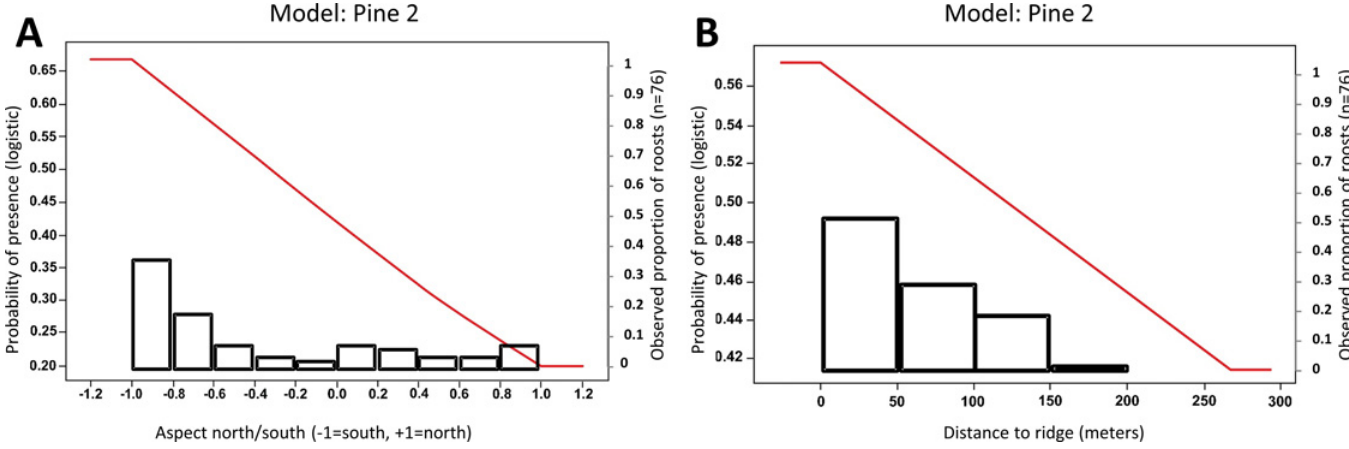
Fig 3. Response curves (red) for aspect North/South (A) and distance-to-ridge (B) for Pine 2. The observed proportions of roosts in each aspect or distance-to-ridge class are plotted as black bars on secondary axes. Pine 2 was one of the two best models developed using a subset of 54 roost locations for female and juvenile Myotis sodalis roosts from May to August, 2008 – 2012 in the southern Appalachian Mountains of North Carolina and